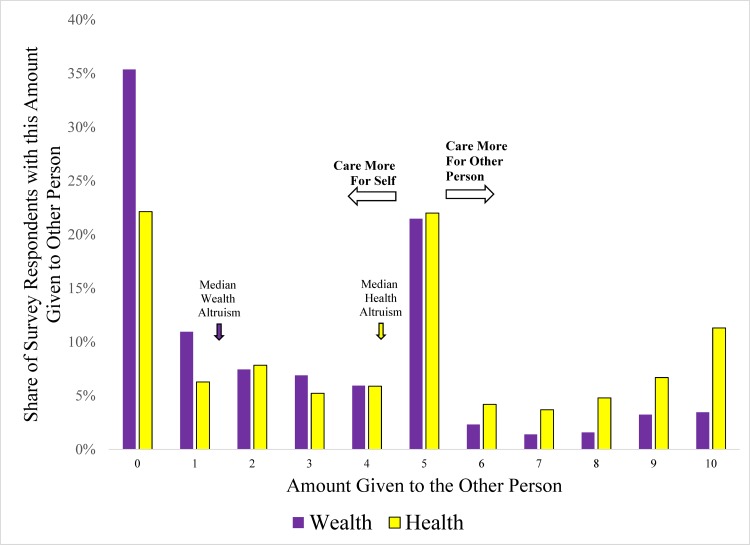
Distributions of levels of health and wealth altruism (survey 1).